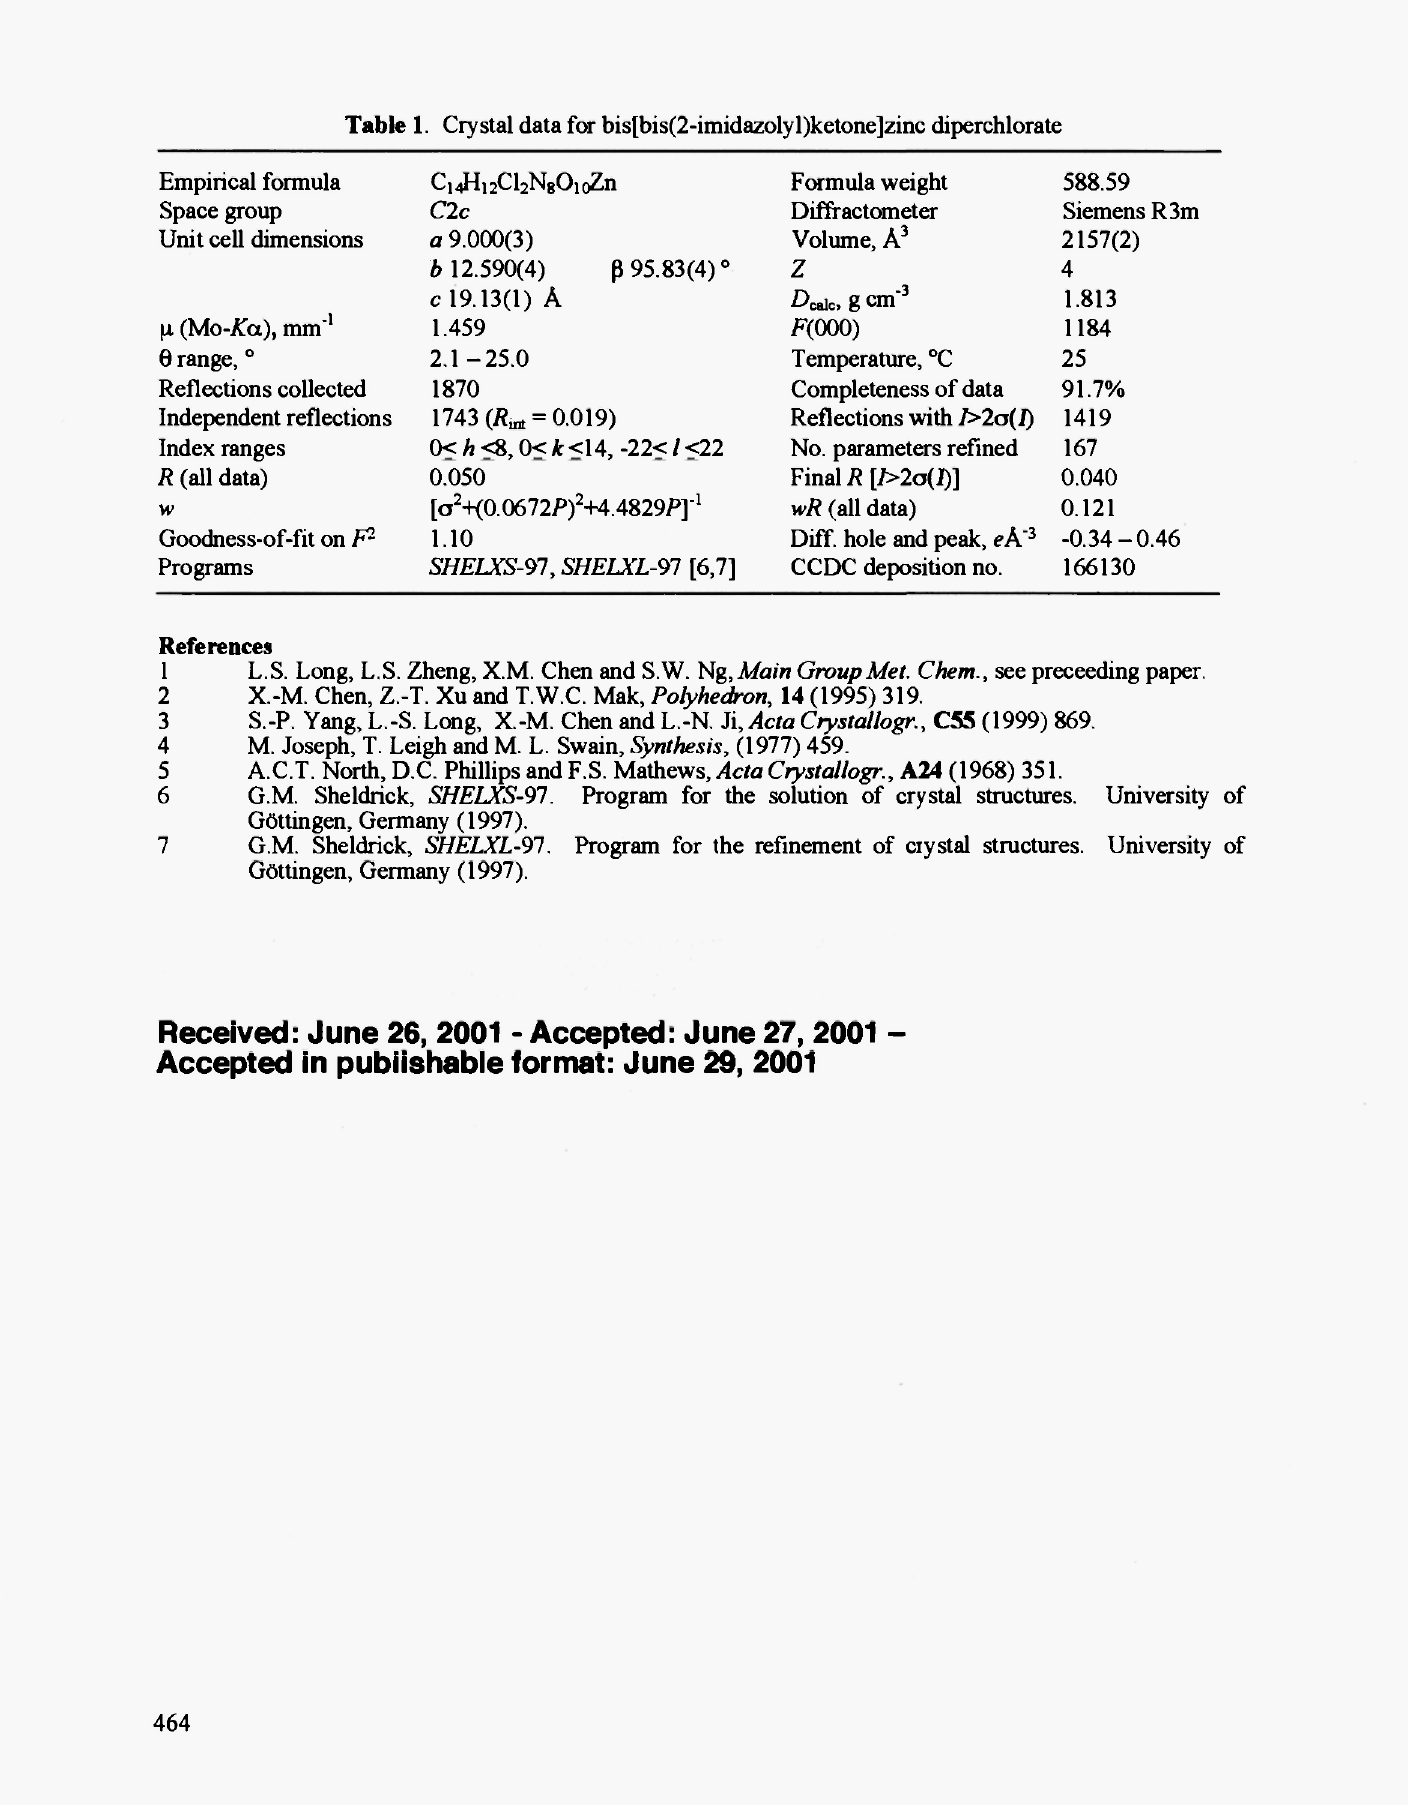
Table 1. Crystal data for bis[bis(2-imidazolyl)ketone]zinc